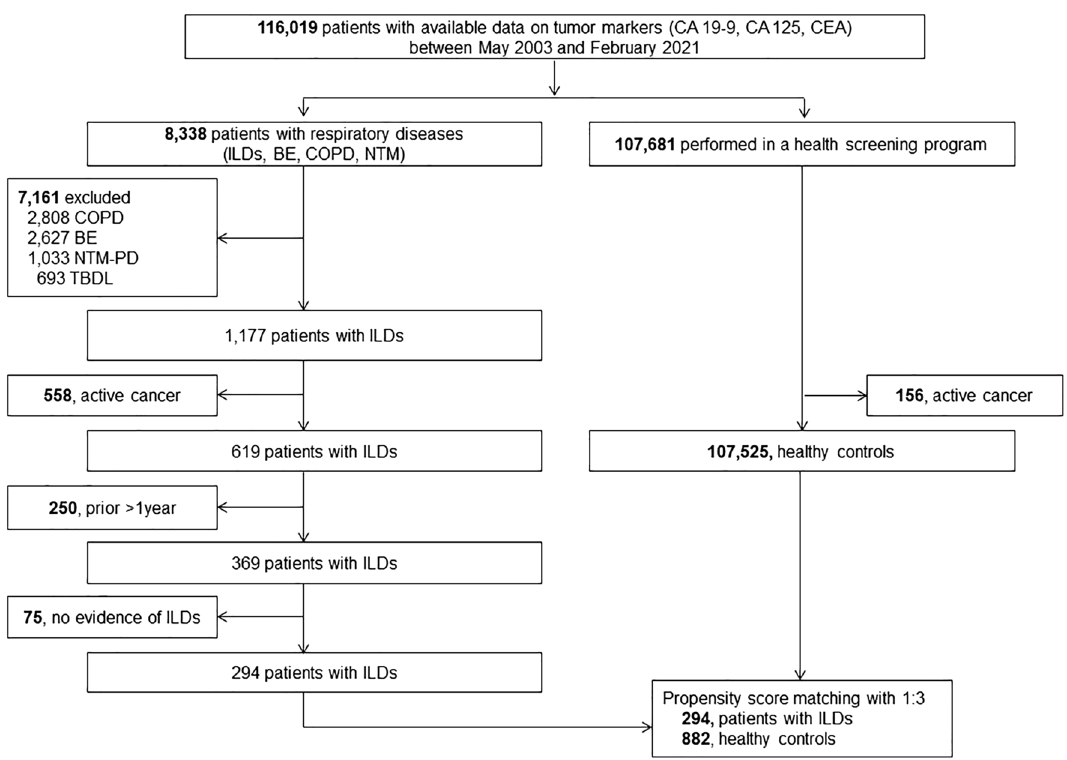
Figure 1. Study flow . CA carbohydrate antigen , CEA carcinoembryonic antigen, ILD interstitial lung disease, BE bronchiectasis, COPD chronic obstructive pulmonary disease, NTM nontuberculous mycobacterium, TBDL tuberculous destroyed lung.